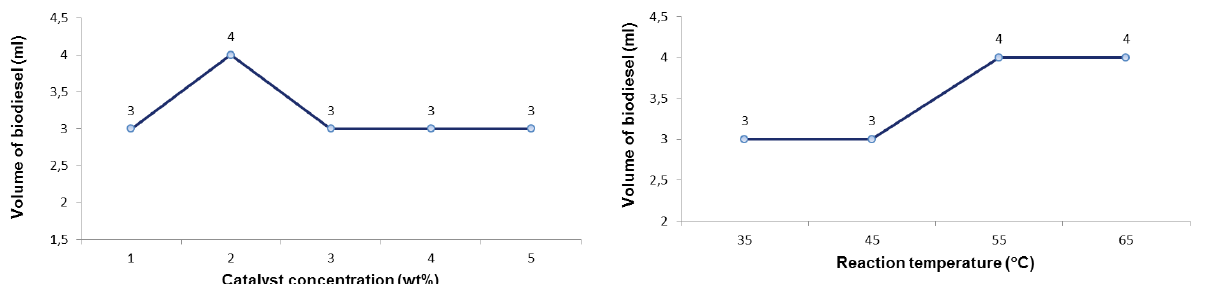
Figure 4: The effect of different catalyst concentrations on the transesterification of used cooking oil. Conditions: reaction time of 2 hours, reaction temperature of 65°C, methanol to oil ratio 4:1.